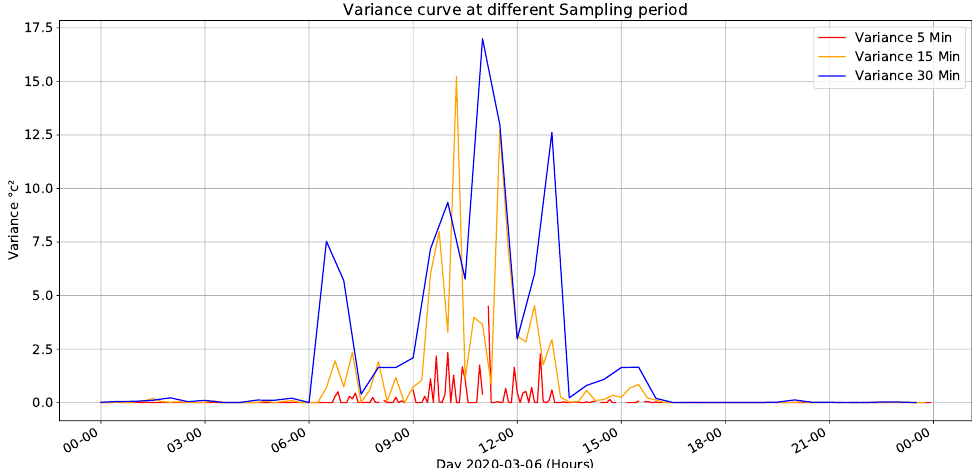
Figure 12. Temperature’s variance for different sampling times.